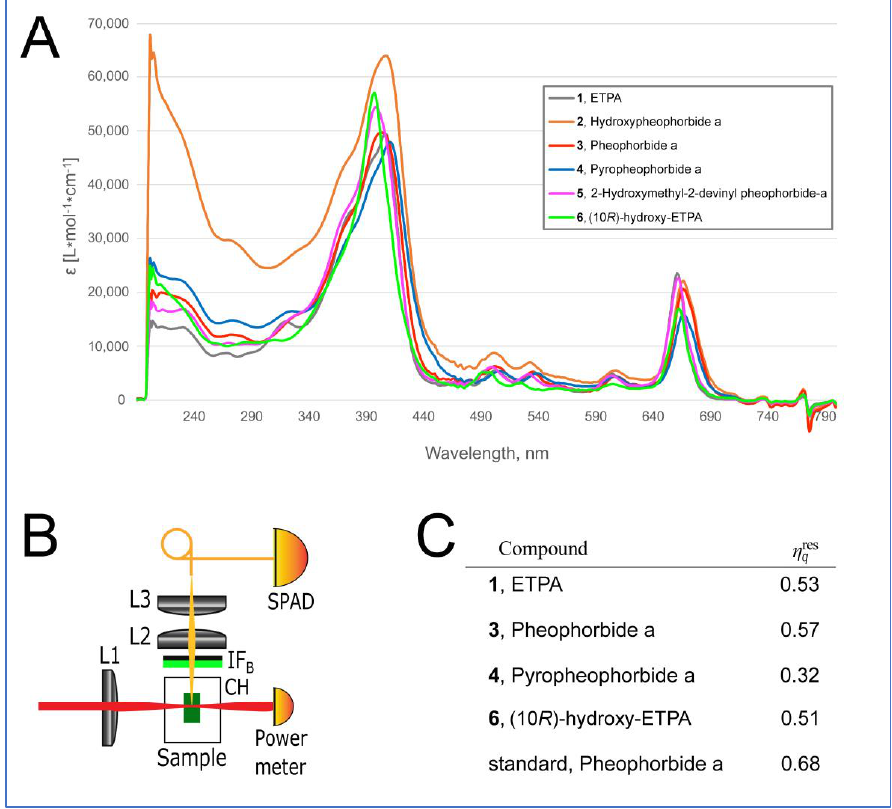
Figure 4. Structures and the yields of the chlorin compounds isolated from O. sarsii .